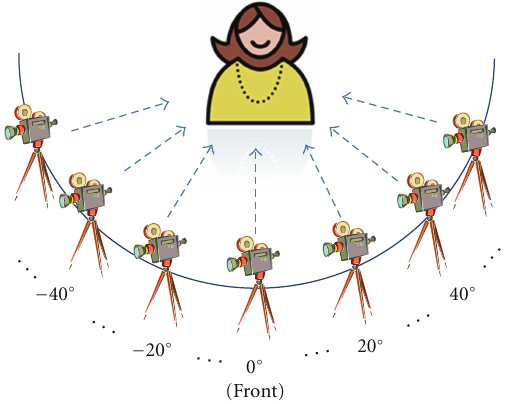
Figure 2: Collection of several face images taken from equal distance but at di ff erent angles.